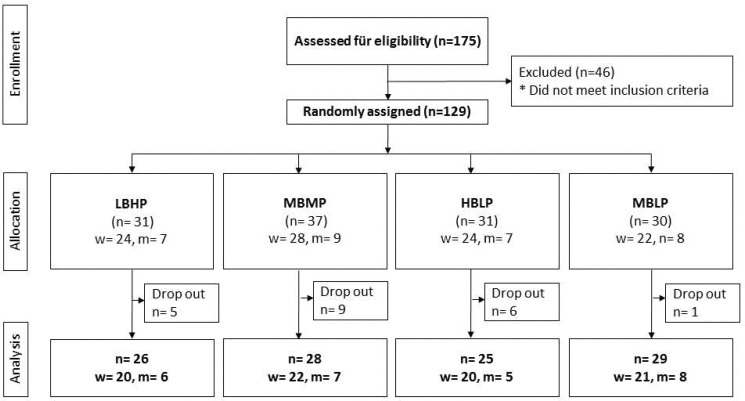
Flow diagram of participants in the trial.